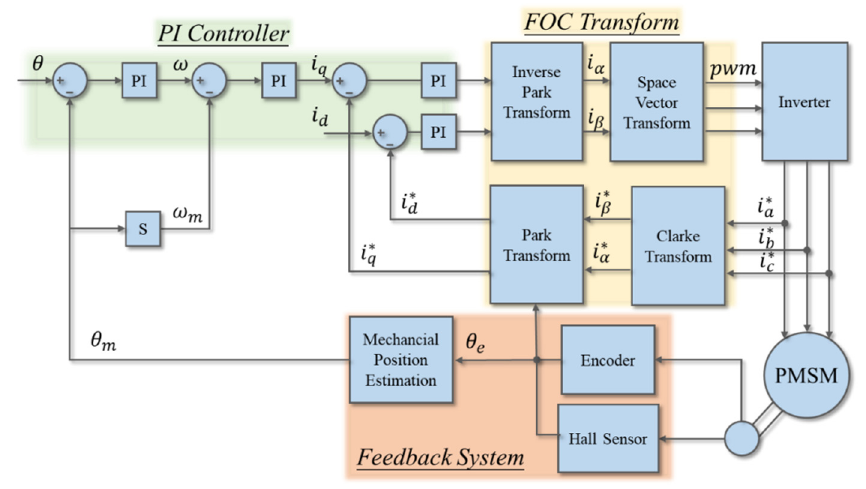
Figure 4. Servo motor drive flow chart.